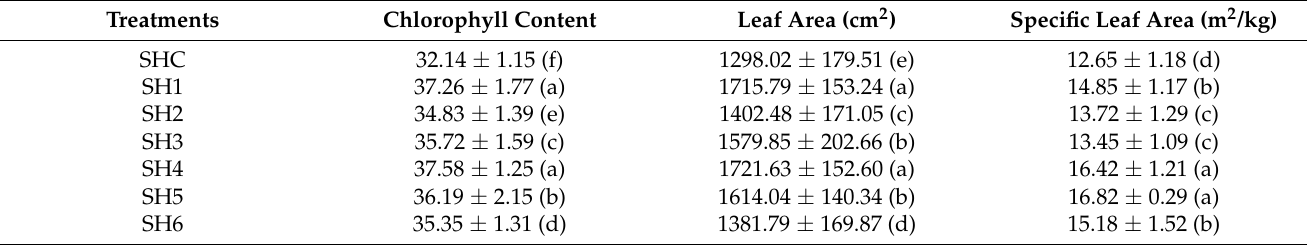
Table 2. The effect of the fertilization regime on chlorophyll content of the leaves (SPAD values), leaf area (cm 2 ) and specific leaf area (m 2 /kg) of S. hispanicus